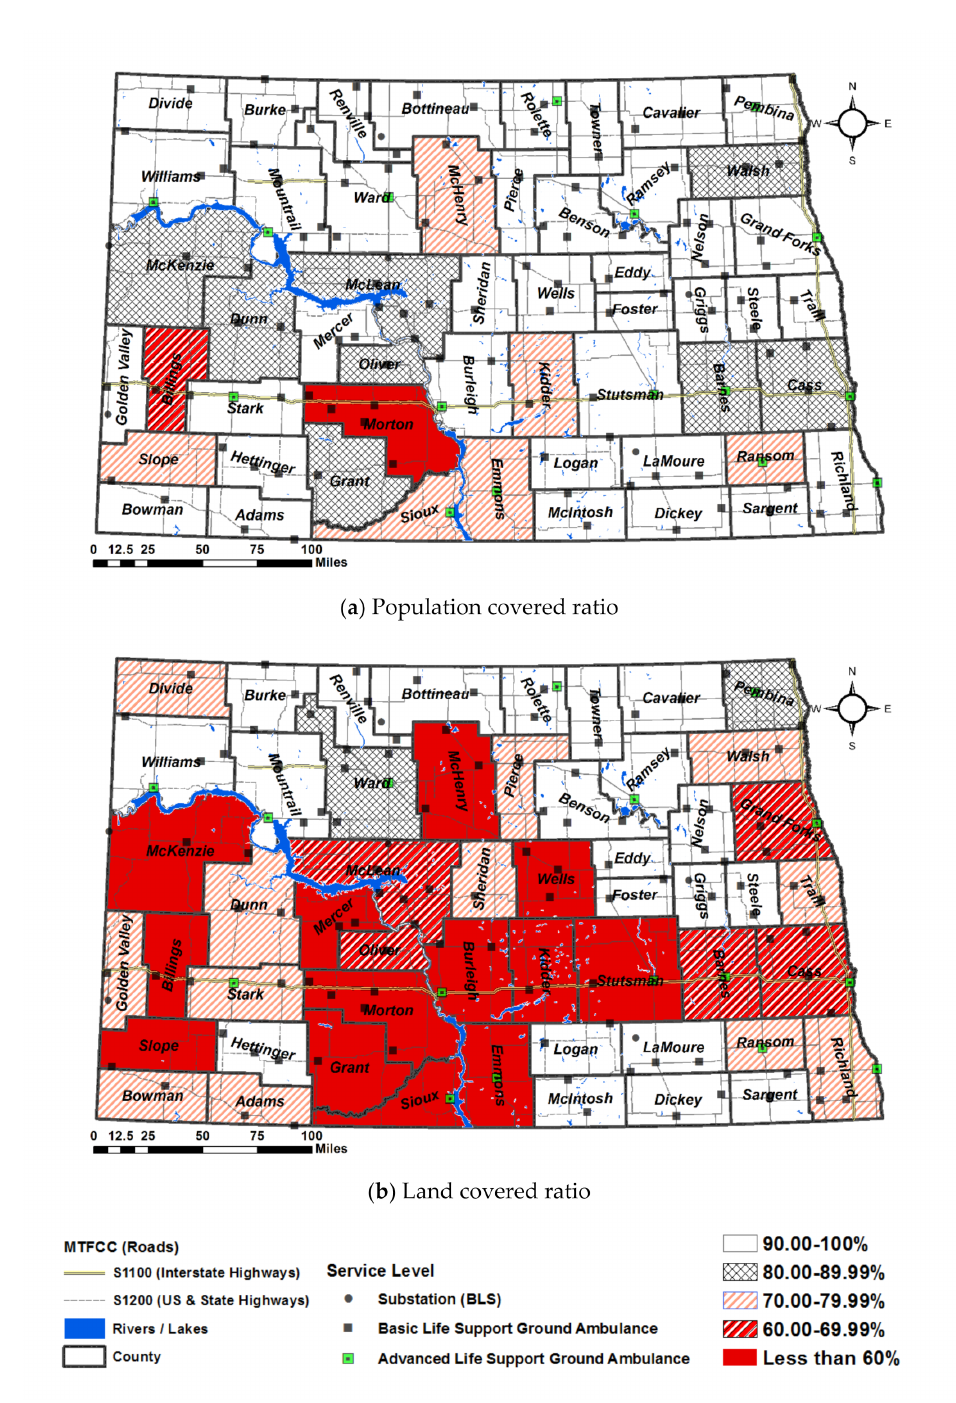
Figure 5. Population covered ratio ( a ) and Land covered ratio ( b ) of Scenario